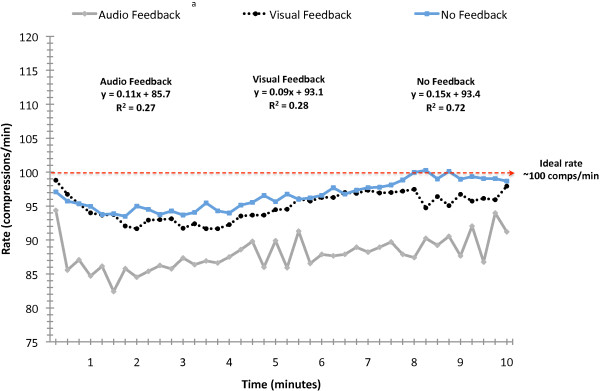
Rate of CPR compressions over 10 minutes. aMain effect for condition (p < 0.001). Auditory feedback yielded significantly slower rate than did no feedback and visual feedback.